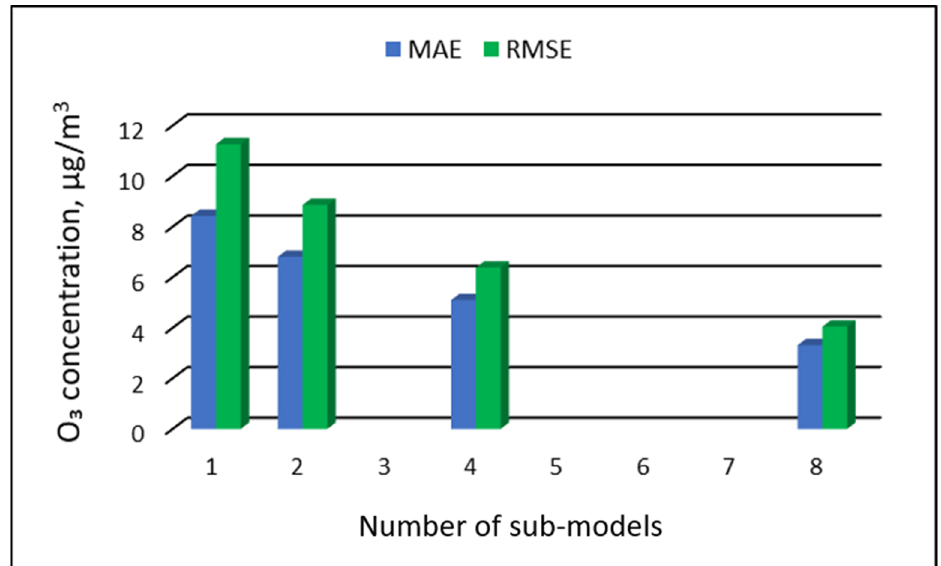
Figure 7. Overall MAE and RMSE values for O 3 concentration prediction in RVS models depending on the number of created sub-models, Zabrze.